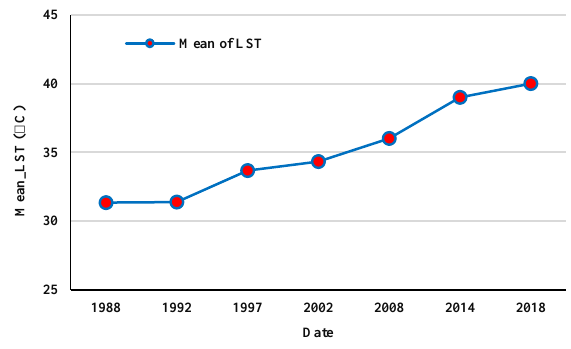
Figure 3. The mean LST of the studied region for 1988 to 2018 (°C).